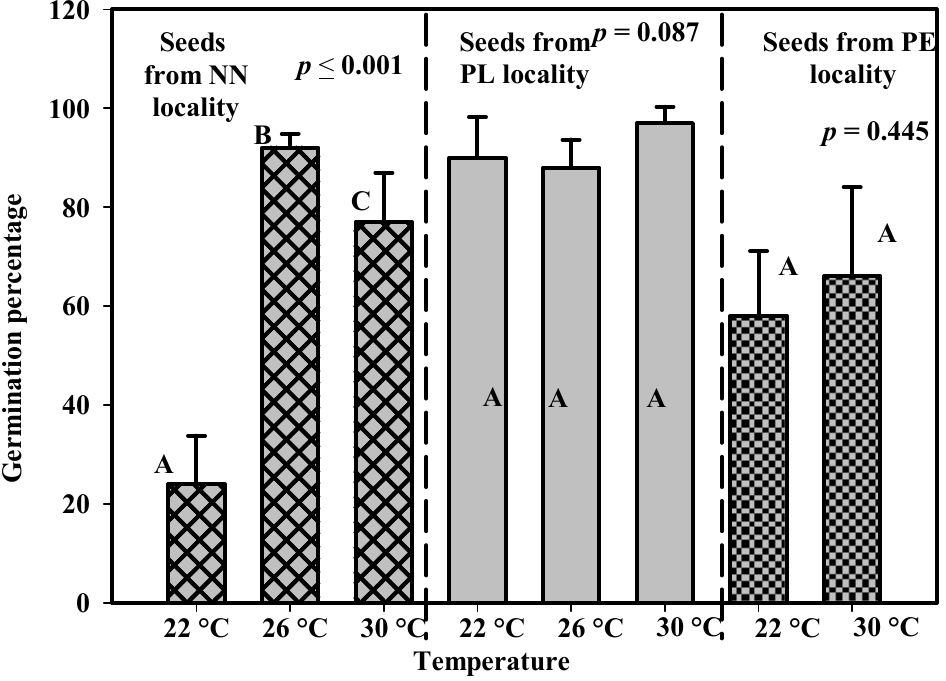
Figure 3. ANOVA results for comparison of the effect of temperature on the final germination percentage (%) of seeds collected in the Sirhin (NN), Firmihin (PL), and Skant (PE) localities. Means with the same letter are not significantly different from each other ( p = 0.05).